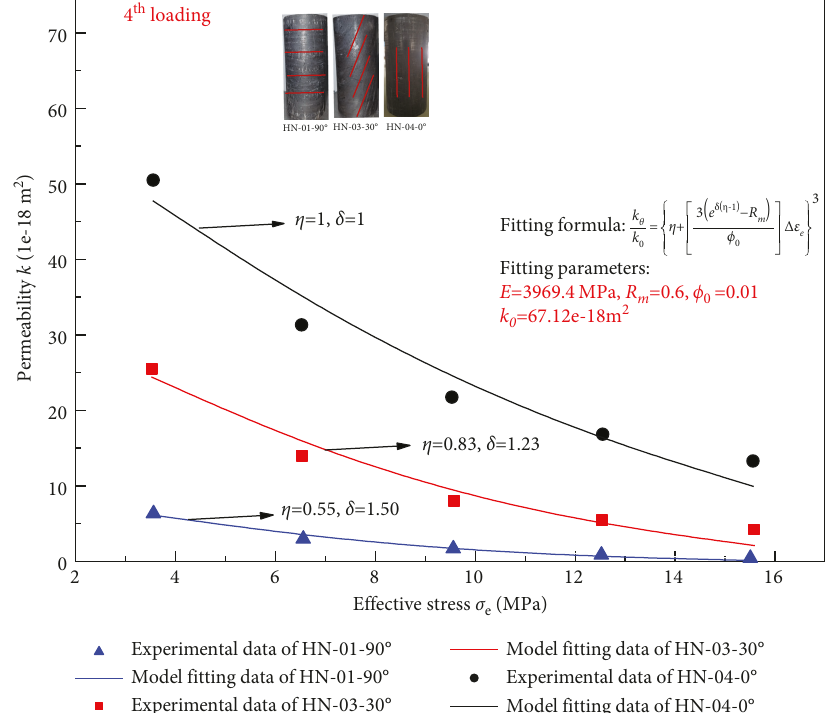
Figure 4: Coal permeability as a function of effective stress. Experimental data are from the 4 th loading period in Yang et al. [29].